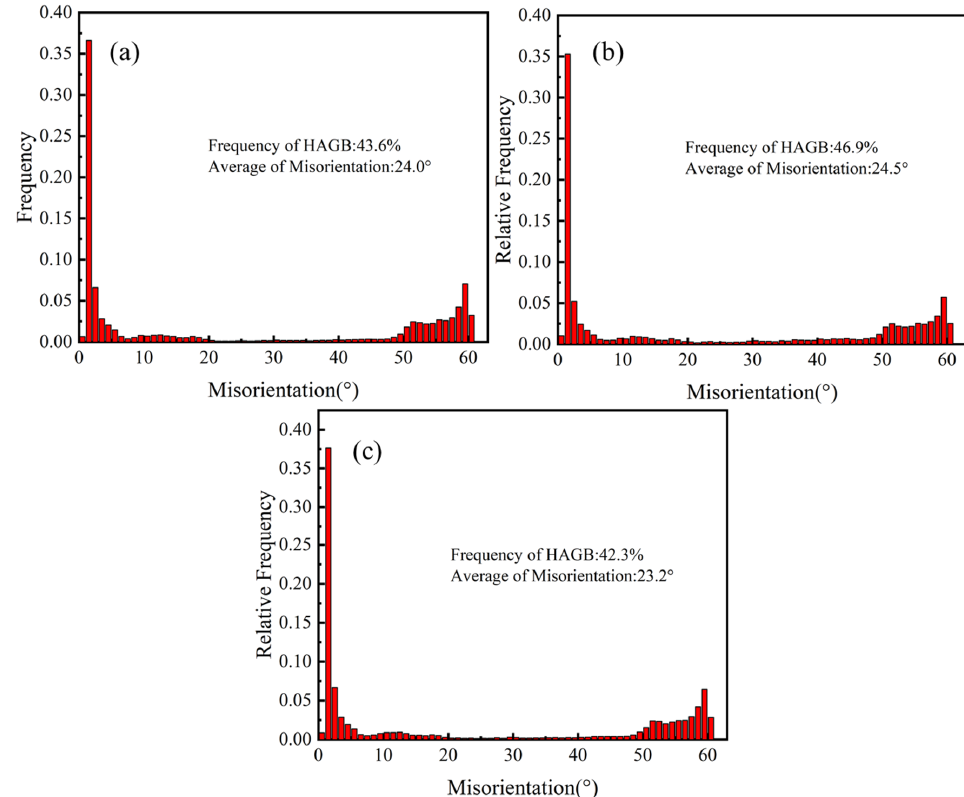
Figure 4. The misorientation of the grain boundaries at varying compression conditions. ( a ) T = 1000 °C, 𝜀 (cid:4662) = 0.1 s − 1 ; ( b ) T = 1100 °C, 𝜀(cid:4662) = 0.1 s − 1 ; ( c ) T = 1000 °C, 𝜀 (cid:4662) = 1 s − 1 . ( a ) T = 1000 ◦ C, . ε = 0.1 s − 1 ; ( b ) T = 1100 ◦ C, . ε = 0.1 s − 1 ; ( c ) T = 1000 ◦ C, . ε = 1 s − 1 .